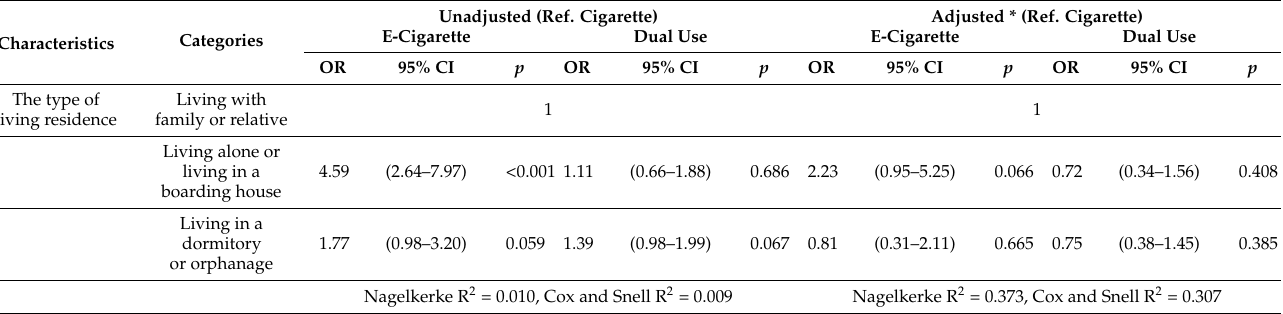
Table 3. The impact of the type of residence of the participants before the COVID-19 pandemic (2019) on the type of tobacco.